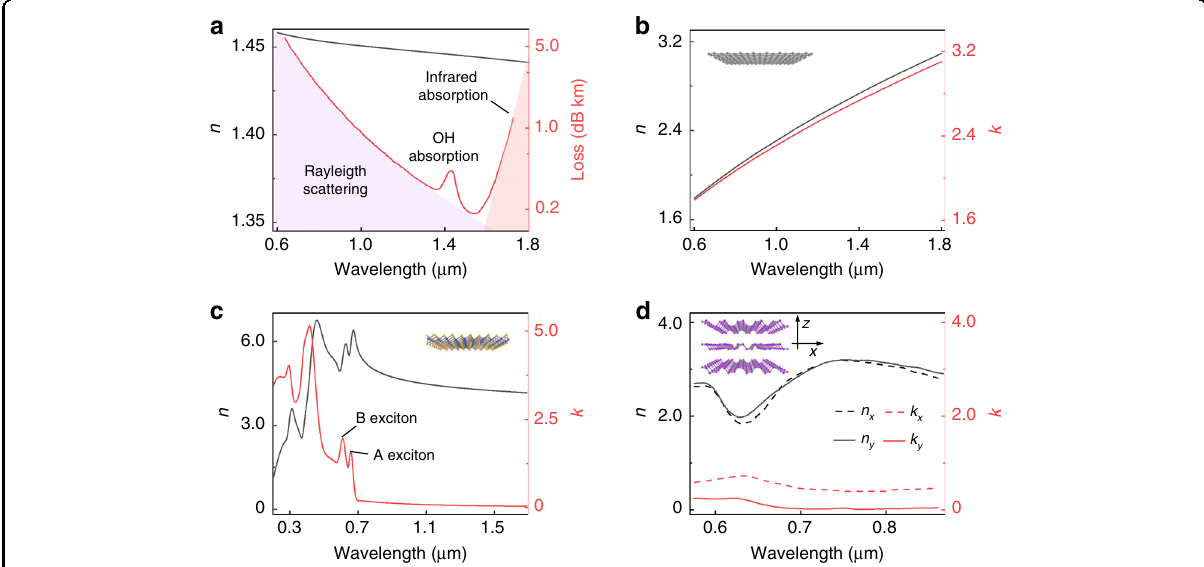
Fig. 2 Optical dispersions of fused silica and 2D materials. a Refractive index n and optical loss (log plot) of silica glass 62 . b Refractive index n and extinction coef fi cient k of monolayer graphene with the following calculated parameters: Fermi level 0.1 eV, scattering time 100 fs, temperature 298 K, graphene thickness 0.34 nm. Optical dispersion ( n , k ) of monolayer MoS 2 ( c ) 115 and thick BP fi lm with strong anisotropy ( d ) 162 . The thickness of monolayer MoS 2 is set as 0.71 nm. a Reproduced from ref. 62 , with the permission of Springer Nature Switzerland AG 2019. c Reproduced from ref. 115 , with the permission of AIP Publishing. d Reproduced from ref. 162 , with the permission of OSA